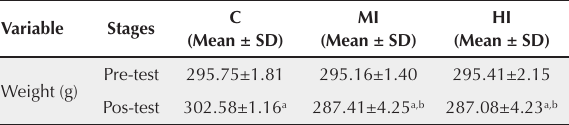
Table 4. The variation of weight in experimental and control groups after eight weeks of aerobic exercise Variable Stages Weight (g)